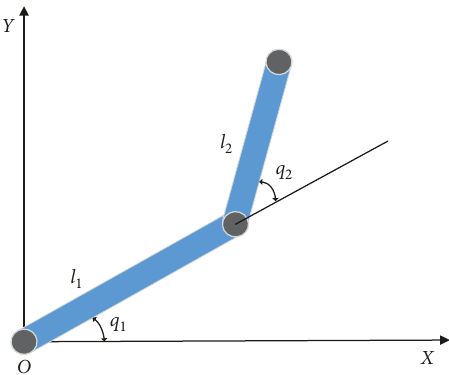
Figure 3: Schematic of the two-link robot manipulator model.